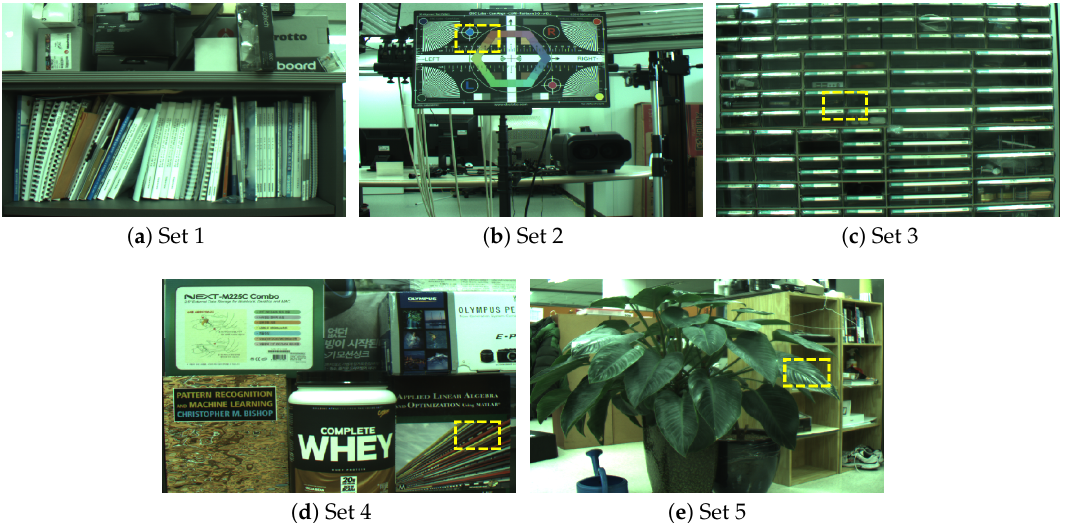
Figure 5. Dataset for the evaluation. As shown From ( a ) to ( e ), we captured highly-textured and various color-distributed scenes for evaluating the proposed method. Yellow-dashed rectangles are the regions to be enlarged for the qualitative comparison presented in Figure